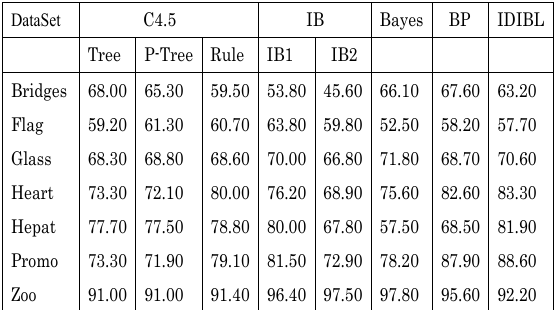
Table 3. Accuracy by conventional algorithms